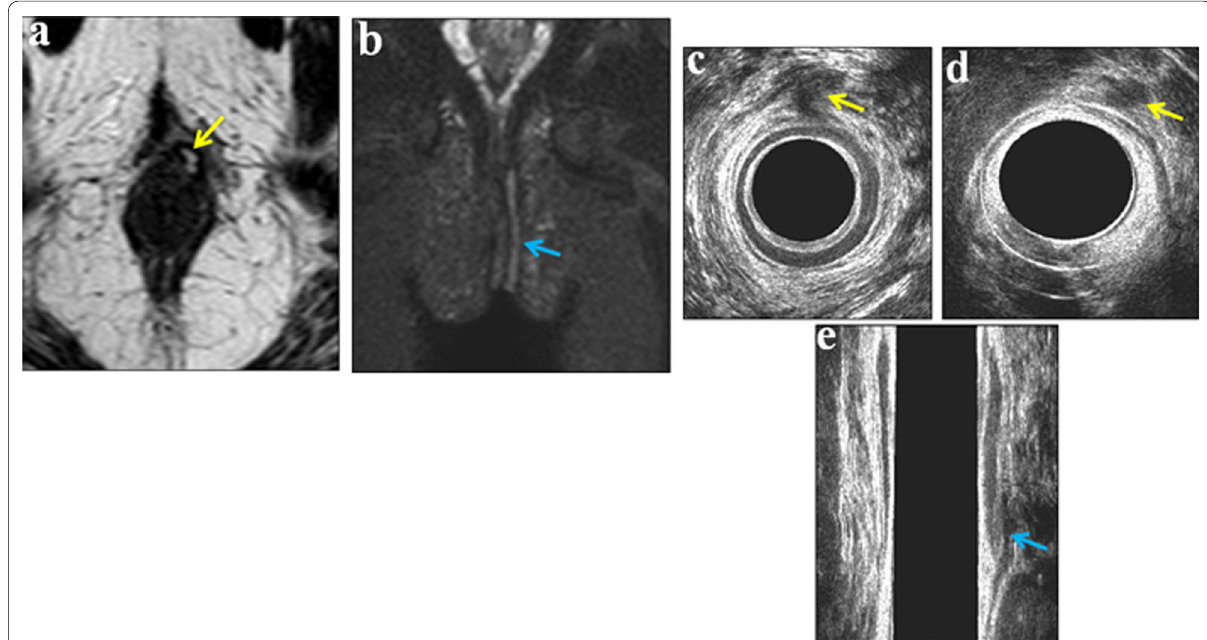
Fig. 2 a MRI axial T2 WI images showing left perianal region trans‑sphincteric fistulous tract breaching the deep part of the external anal sphincter opposite 1 o’clock (yellow arrow). b MRI coronal STIR WI images showing high signal trans‑sphincteric fistulous tract ending just below the inferior margin of the left puborectalis (blue arrow). c , d ultrasound axial images show left hypoechoic trans‑sphincteric fistulous tract breaching the subcutaneous and deep portions of the left external anal sphincter at 12–1 o’clock (yellow arrows). e Post reconstruction ultrasound coronal images show left trans‑sphincteric fistulous tract breaching the deep and superficial portions of the external sphincter (blue